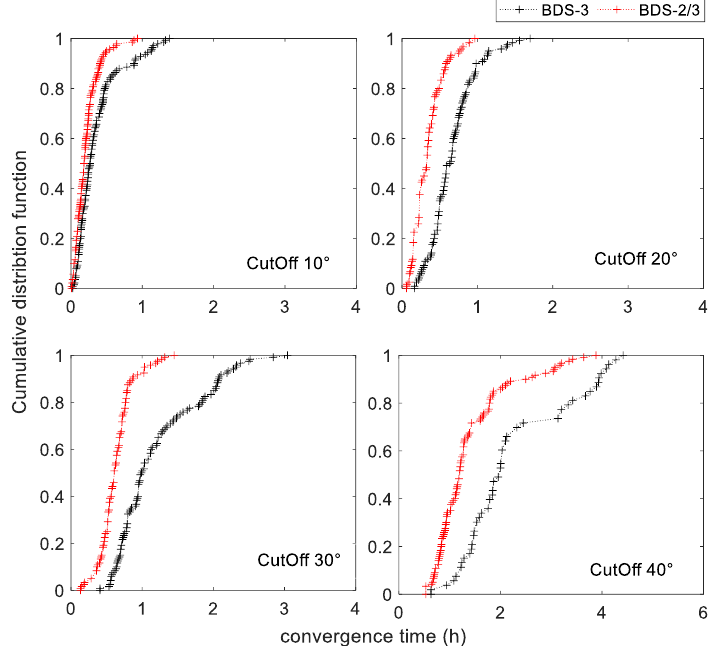
Figure 5. The convergence time comparison between the two combinations. The cumulative distribu- tion function curve.